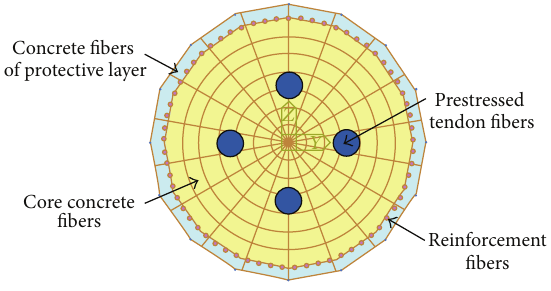
Figure 1: Schematic diagram of fiber section.